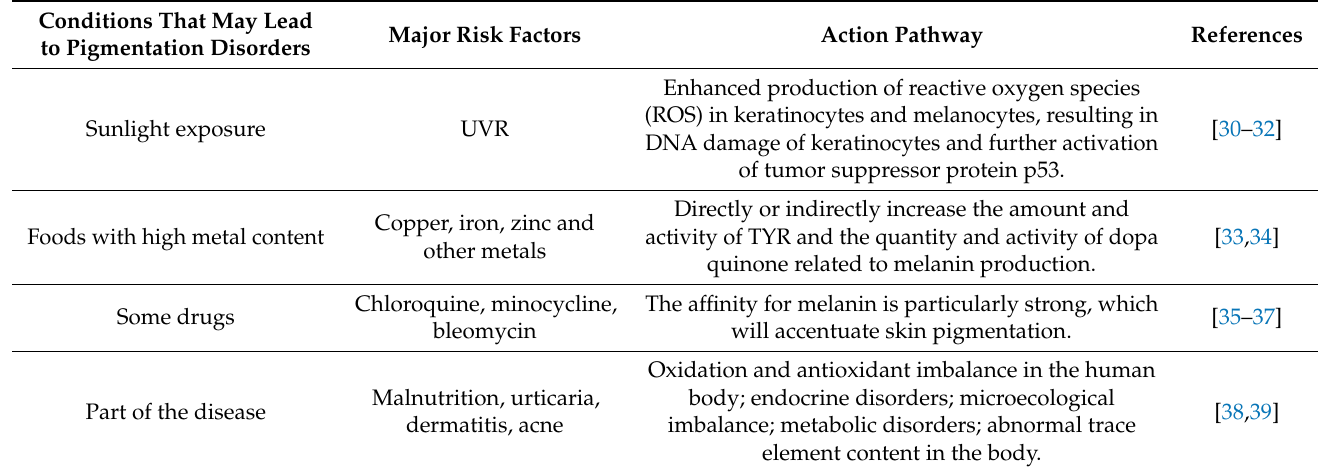
Figure 2. Schematic drawing of melanin synthesis, regulation, and transfer in melanocytes of skin epi- dermis and skin dullness. ( A ) Melanin produced by melanocytes is internalized by keratinocytes and then migrates and distributes to the surrounding membrane area, providing pigmentation. ( B ) Many cytokines activate signaling pathways by interacting with receptors on the melanin membrane and regulate the melanin production process through MITF. ( C ) Melanin production and transfer process (Created with BioRender.com, accessed on 20 October 2022). Table 1. Risk factors for pigmentation and their action pathways.